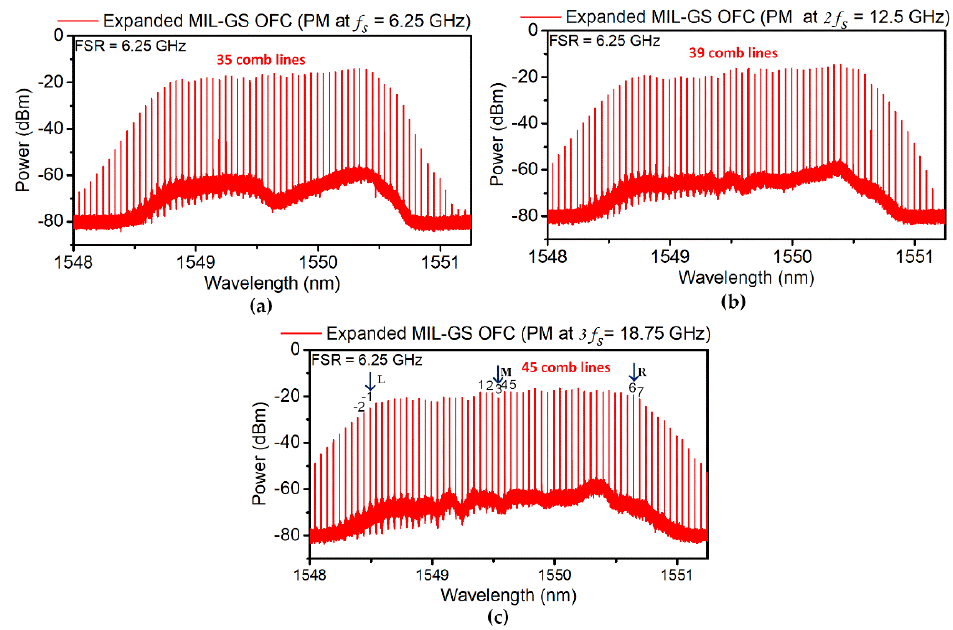
Figure 4. Optical spectra of expanded MIL-GS OFC, PM driven at ( a ) 6.25; ( b ) 12.5, and ( c ) 18.75 GHz. The arrows (L: left, M: middle, R: right) and numbered tones are filtered for phase noise analysis. Table 2. Summary of the OFC expansion at FSR of 6.25 GHz.